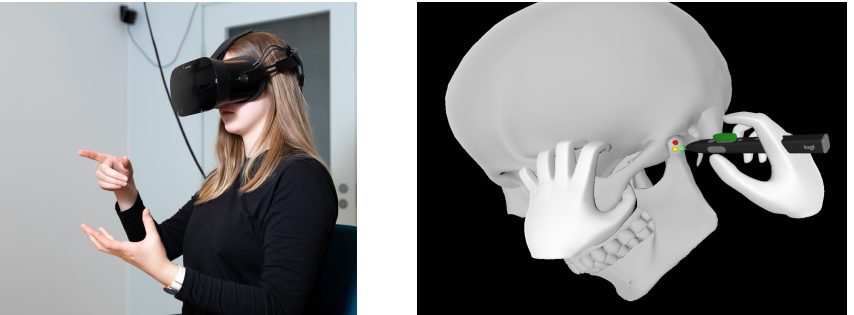
Figure 2. Hands interaction method outside VR ( left ). Hands marking method inside VR and the study task ( right